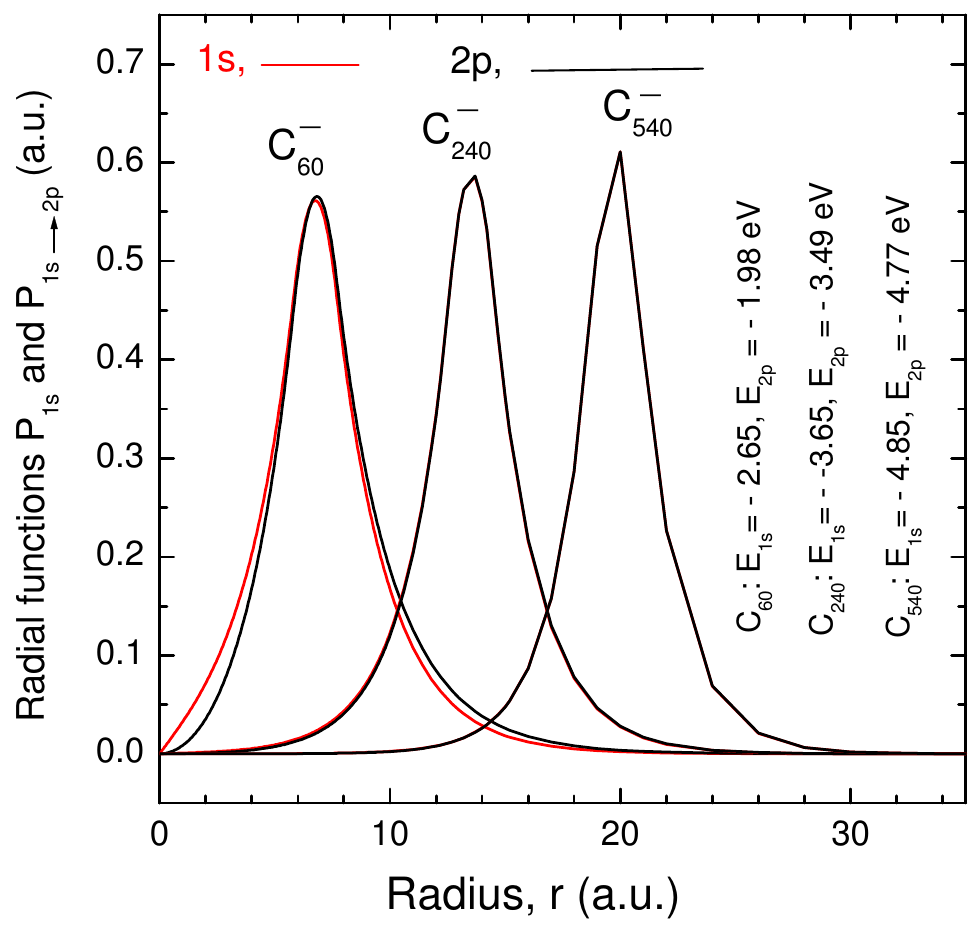
Figure 1. Calculated ground-state P 1 s ( r ) and excited- state P 2 p ( r ) radial functions and corresponding E 1 s and E 2 p binding energies of the attached electron in C −